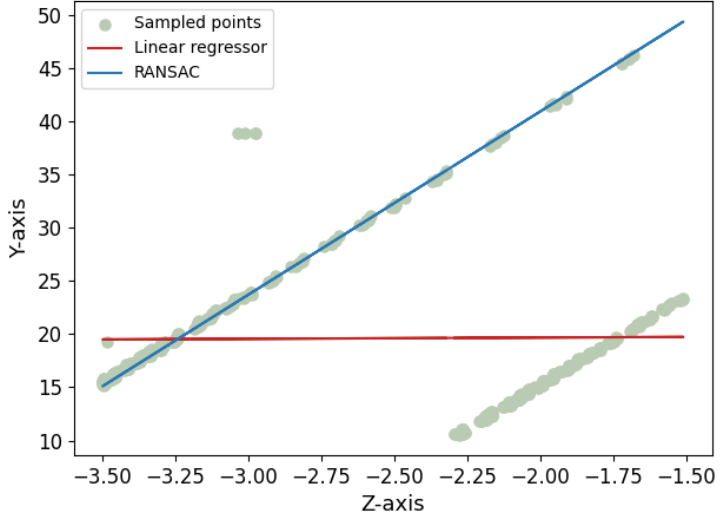
Figure 4. Comparing the fitting effect of the RANSAC algorithm and the linear regressor algorithm.